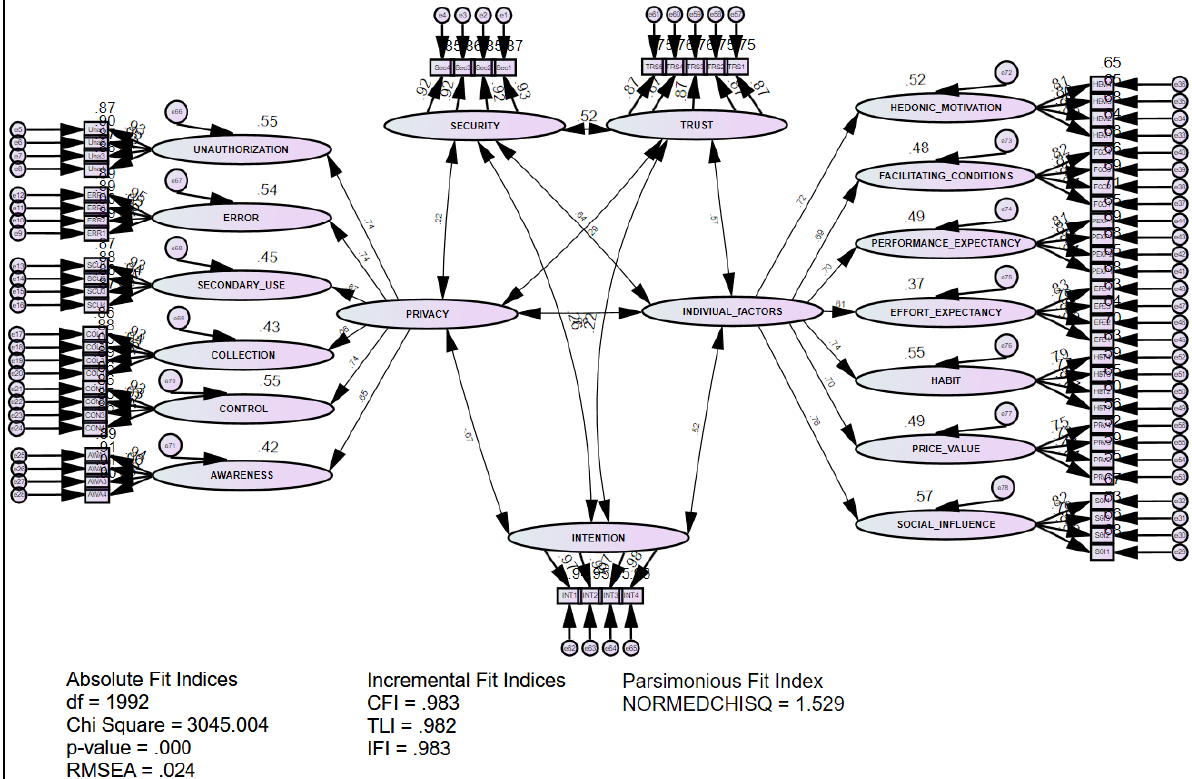
Figure 2. The CFA Model